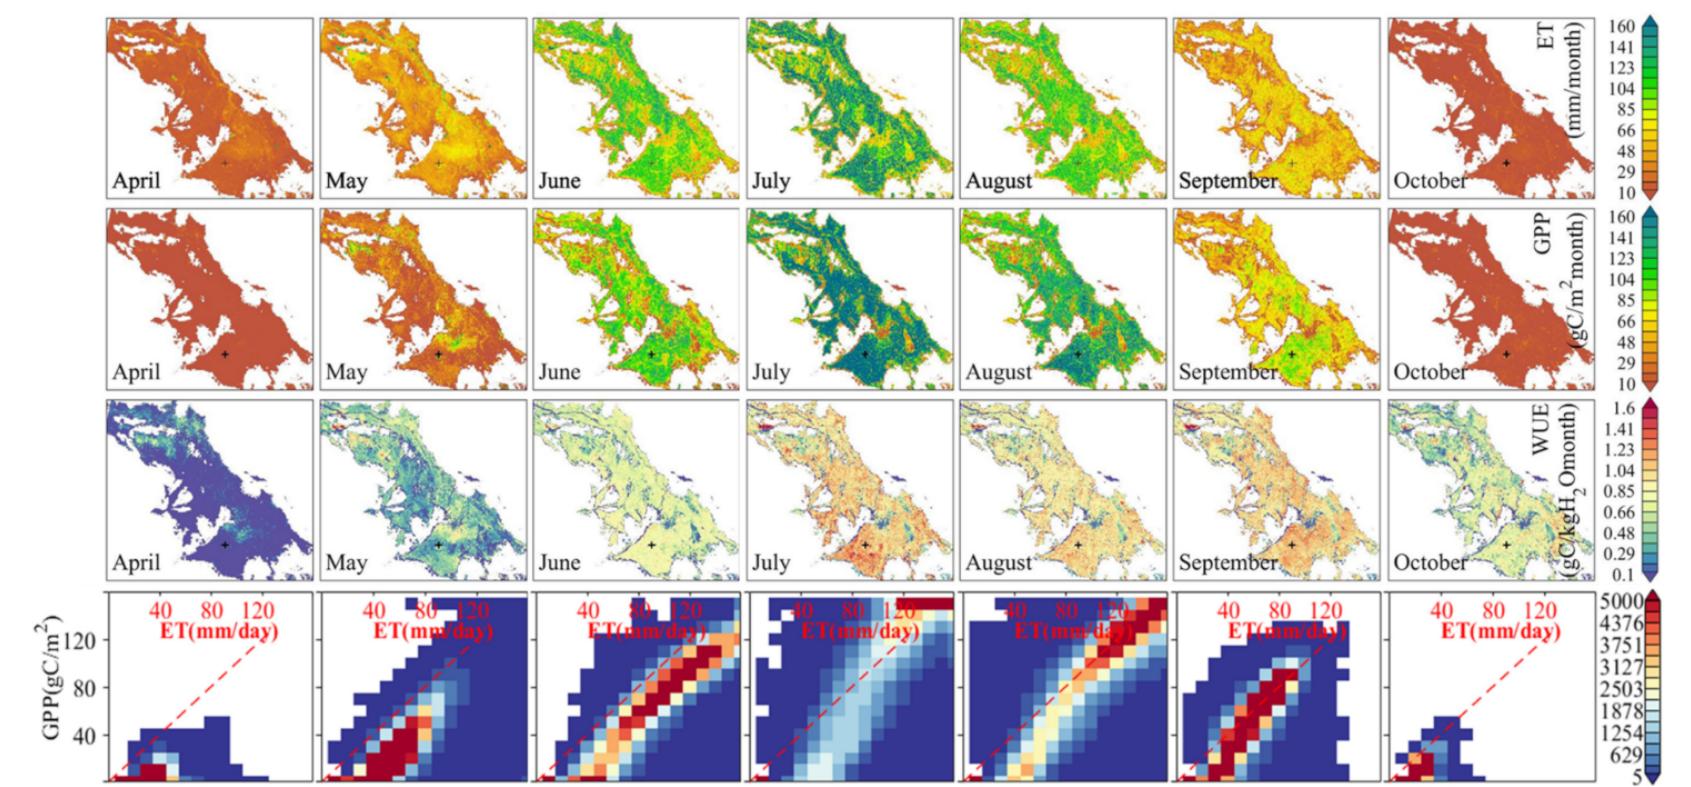
Figure 8. Spatial time series for monthly ET (row 1), GPP (row 2), and WUE (row 3), and bivariate histograms (count) between ET and GPP (row 4) over midstream oasis agricultural areas. Black plus sign indicates location of DMS. Data from 2013 were selected as an example of detailed spatial distribution